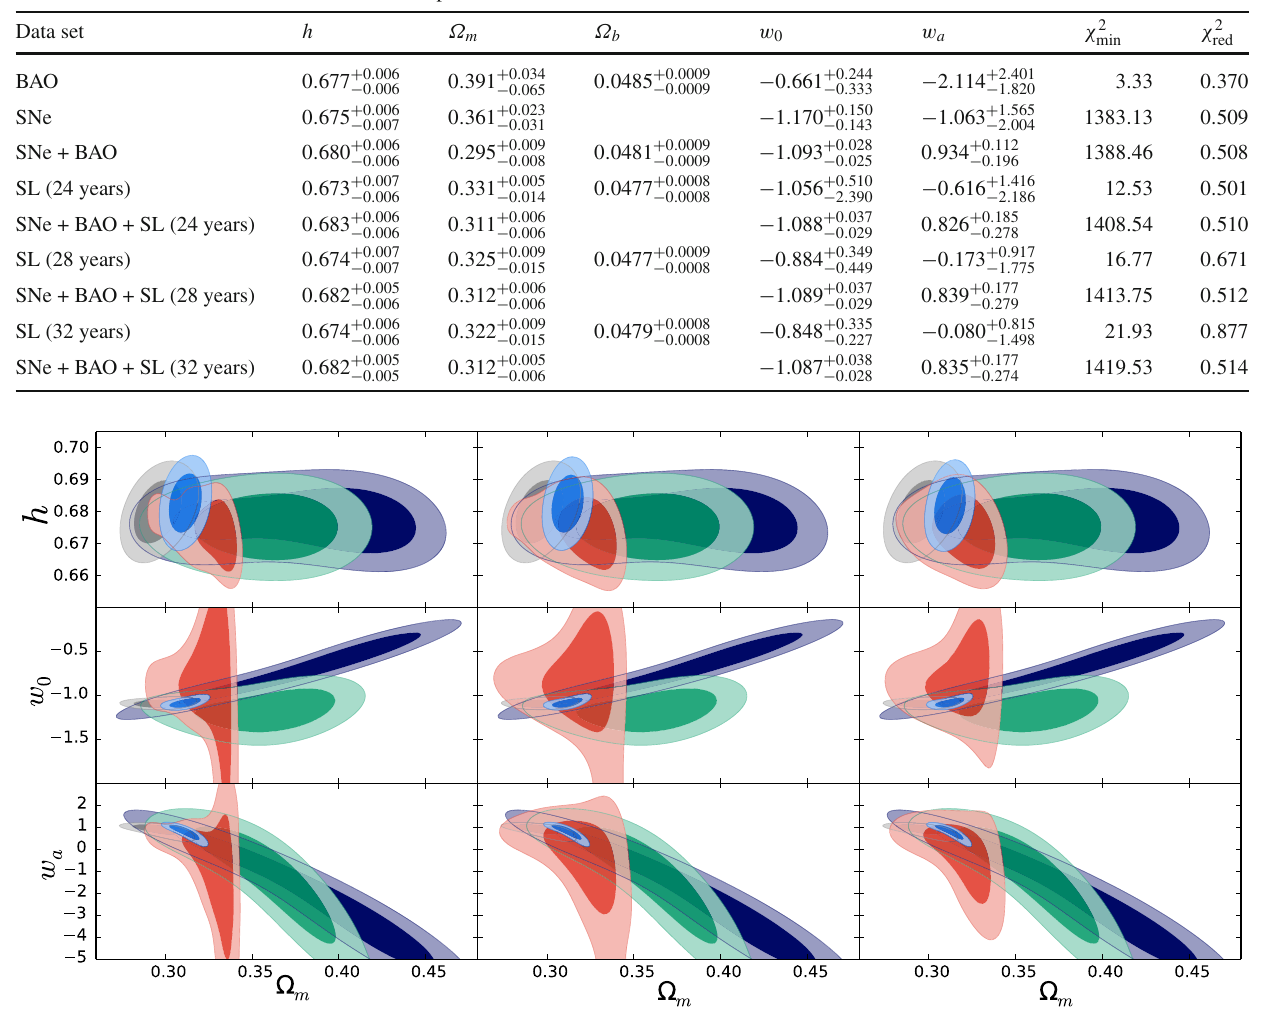
Fig. 8 Lazkoz–Sendra pivotal model; solid contours limit 1 σ regions and clear contours 2 σ region. Purple for the BAO, green for SNe and red for SL data set, gray for SNe + BAO and blue SL + BAO + SNe. First set (left) for 24 years, second (middle) for 28 and third (right) for 32